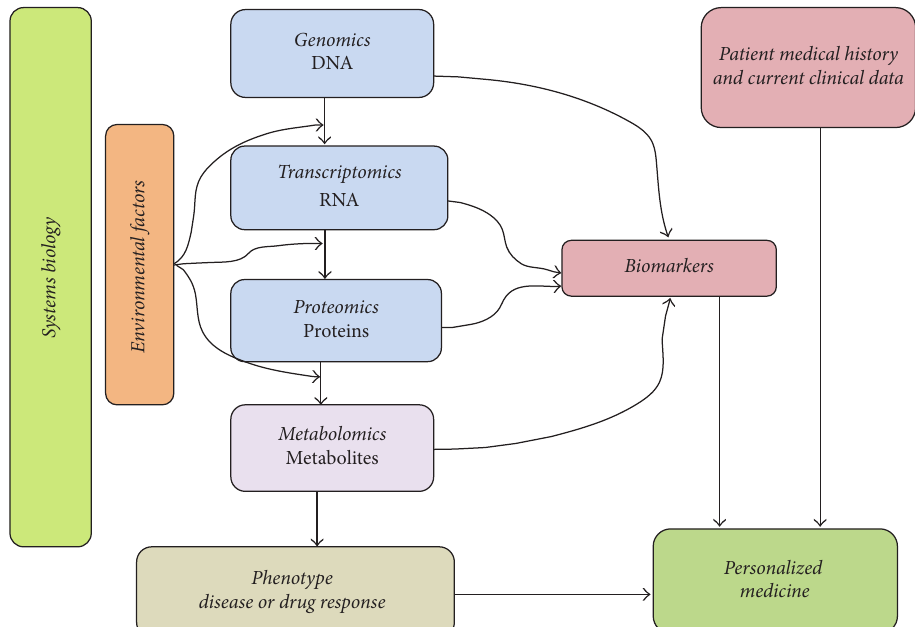
Figure 2: The role of Systems Biology in Personalized Medicine. The figure elucidates how all “Omics” disciplines can provide phenotype biomarkers (disease or drug response biomarkers). Together with patient medical history and current clinical data, these biomarkers can help to personalize patient’s therapy. The metabolomics is the ultimate “Omics” that is close to the phenotype, as well as reflecting the perturbation in other “Omics.” This figure is adapted and modified with permission from the publisher. Original source: Louridas and Lourida (2012). Published by Hippokratia . All rights reserved